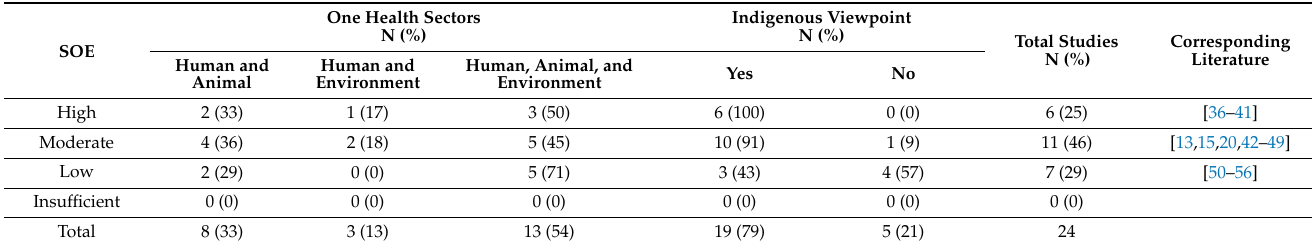
Figure 1. Inclusion flow chart. Table 2. SOE by One Health sector and indigenous